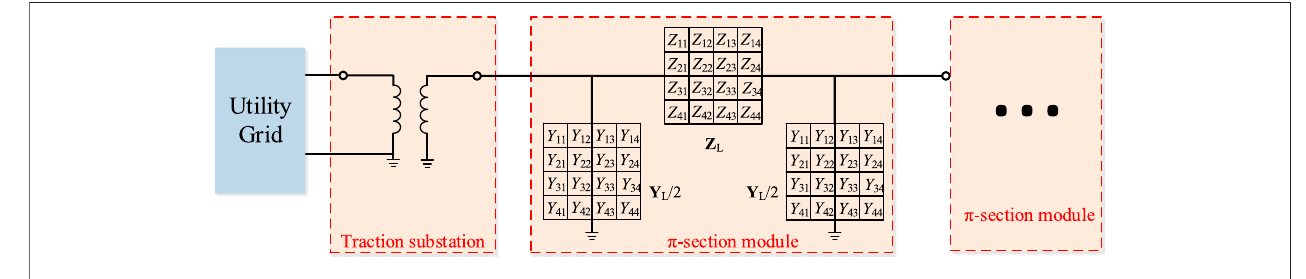
FIGURE 9 | The π -section module of the traction network.